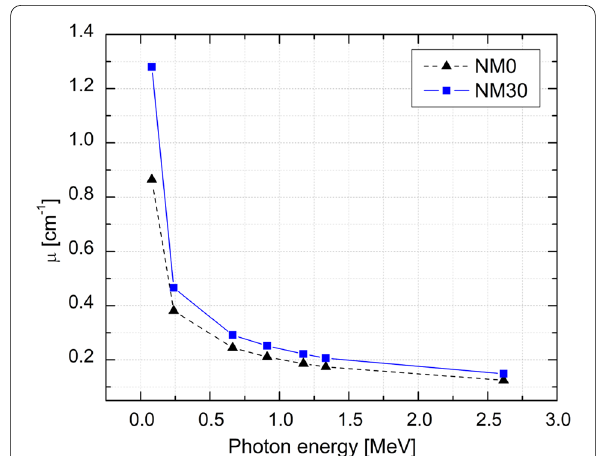
Fig. 11 Experimental linear attenuation coefficients of NM30 and NM0 as a function of photon energy